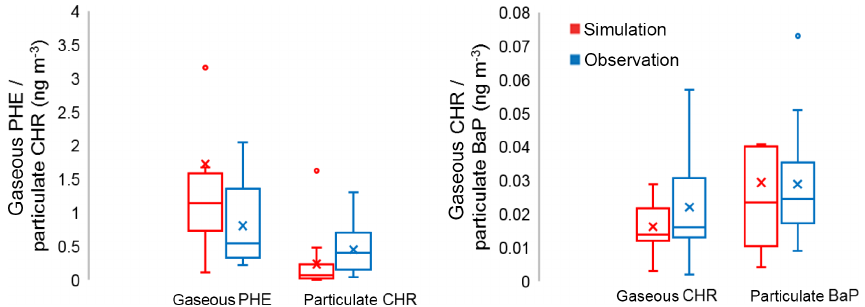
Figure 5. Simulated (red) and observed (blue) concentrations of gaseous PHE, particulate CHR, gaseous CHR and particulate BaP at the Gosan site averaged over 14–25 February 2003. The line and “X” in each box are the median and mean, while the boxes represent the 25th and 75th percentiles. Upper whisker is quartile 3 (Q3) + 1.5 × interquartile range (IQR) or maximum value, whichever is smaller; lower